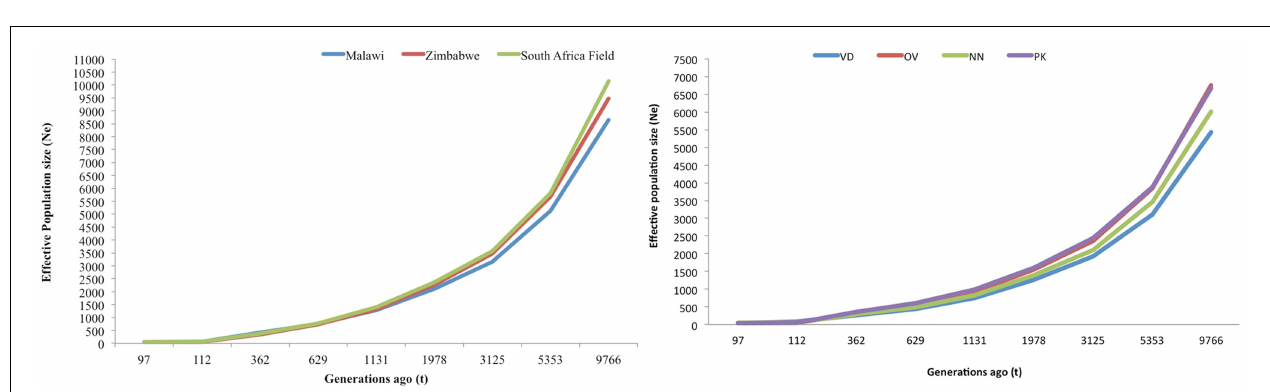
decay with increased physical distance between SNPs for macro-chromosomes 1–5. VD, Venda conservation flocks; NN, Naked Neck conservation flocks; OV, Ovambo conservation flocks; PK, Potchefstroom Koekoek conservation flock; SAField, village chickens from South Africa; Zimbabwe, village chickens from Zimbabwe; Malawi, village chickens from Malawi.